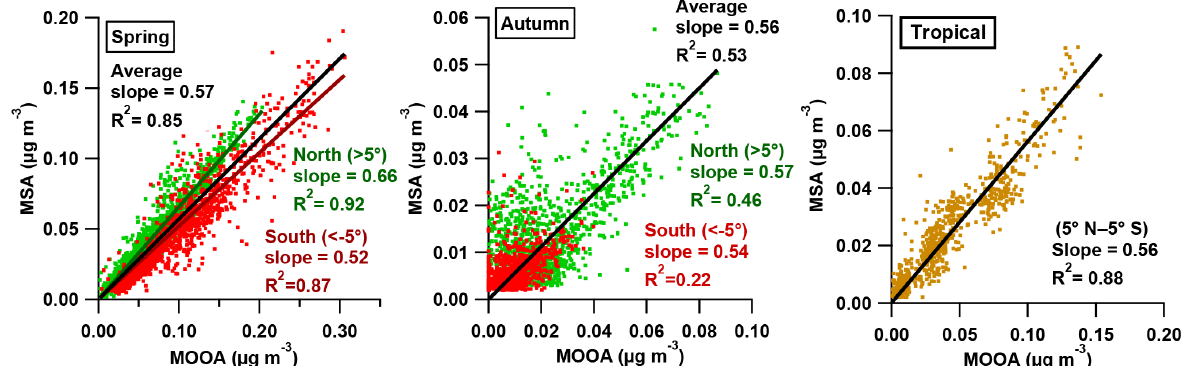
Figure 7. The correlations between the MSA and MOOA factor in spring and autumn over different regions of the Atlantic